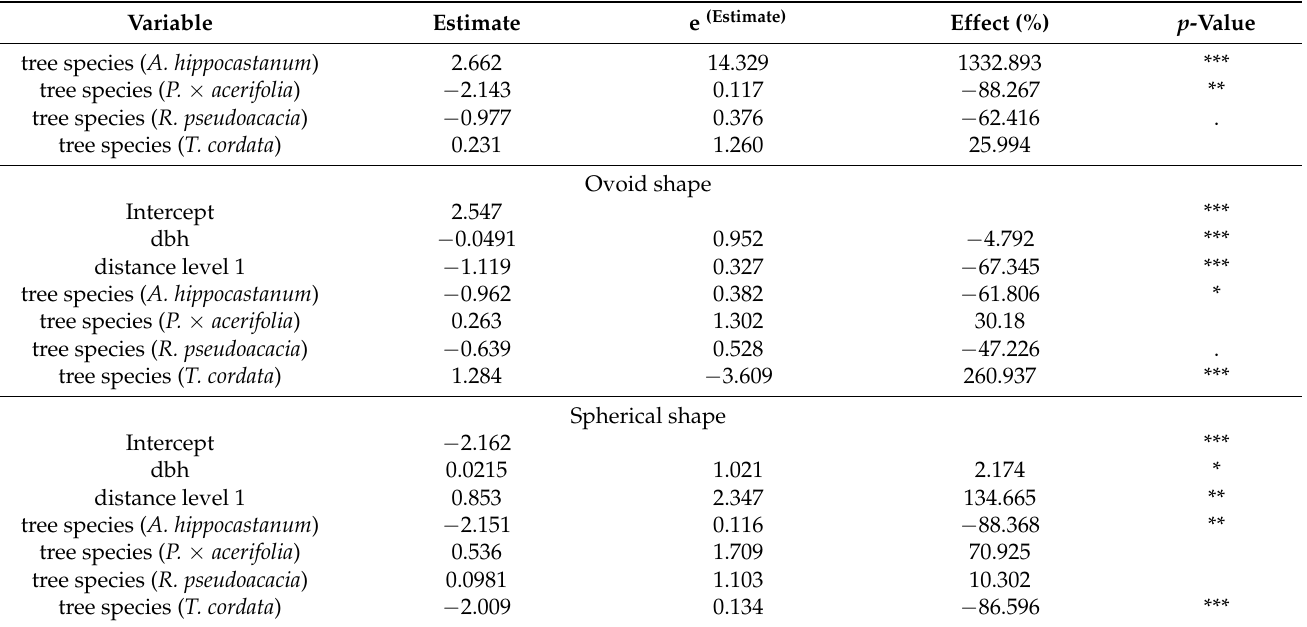
Figure 8. Percentage distribution of crown shapes for the different tree species for two distance clas- ses of the closest object. 3.6. Influence of Crown Shape on the Shade Area and the Shade Density Resolving the exponential equations for the natural logarithm, an increase of 10% in dbh (x) resulted in an increase of the shade area of 0.43% for ovoid shaped crowns and 0.36% for the half-ellipsoid shape. The shade area for cylindrical shaped crowns did not increase strongly with age (0.2% per 10% increase in stem diameter) (see Figure 9). In con- trast, the shade density of the trees showed almost reverse patterns for the different crown forms depending on dbh (Figure 10), with decreasing shade density for every species and the lowest decrease for the cylindrical shape ( − 0.03% per 10% increase in stem diameter). For example, a tree measuring 60 cm dbh with a spherical shape has a mean shade area of 323.1 m², while a cylindrical shaped tree has a mean shade area of 184.6 m². A tree with a half ellipsoidal or an ovoid crown, in contrast, has a smaller mean shade area, respectively, of 124.3 m² and 114.2 m². Smaller trees, measuring 40 cm dbh, also show for the spherical and cylindrical crown the highest shade area values (198.3 m² and 120.8 m²).